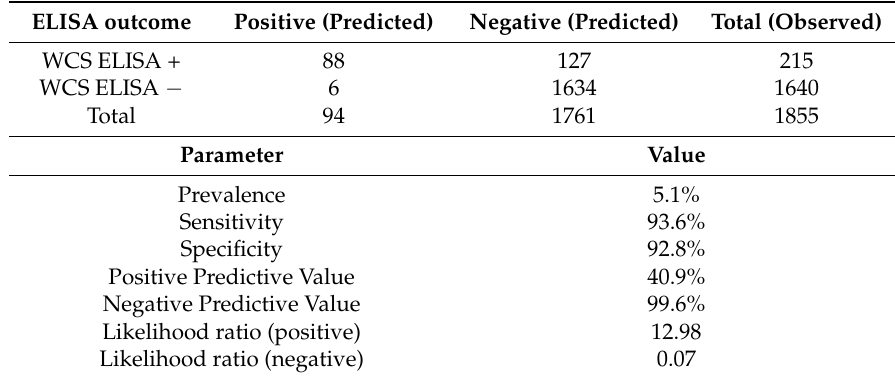
Table 2. Evaluation of WCS ELISA test parameters for seroprevalence of Lyme disease given 215 positive test results in a population of 1855 individual